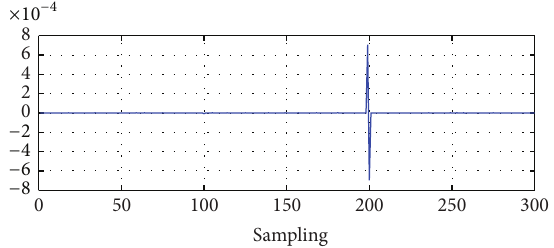
Figure 4: Slope error detection based on Gaussian wavelet transform.